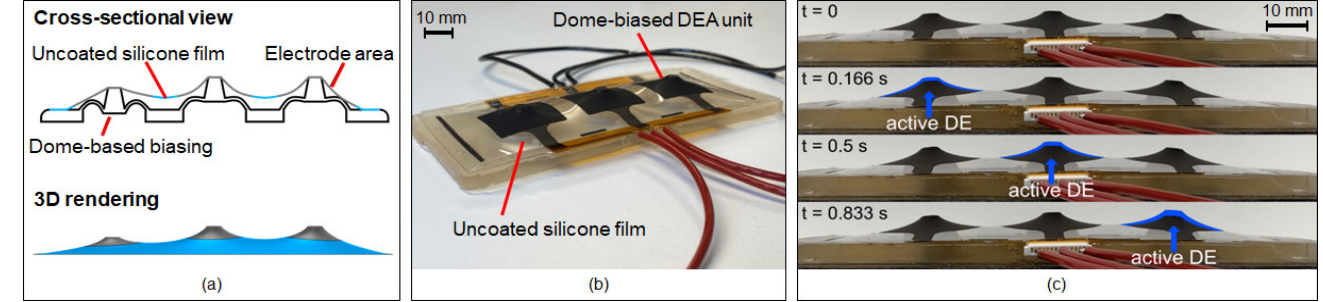
Figure 2. 3 × 1 DEA membrane w/CB/PDMS electrodes ( a ), test rig for coupling characterization ( b ), center DE actuation properties unaffected by neighbor deflection ( c ), center DE sensing properties capable of self-detection and neighbor detection ( d ).